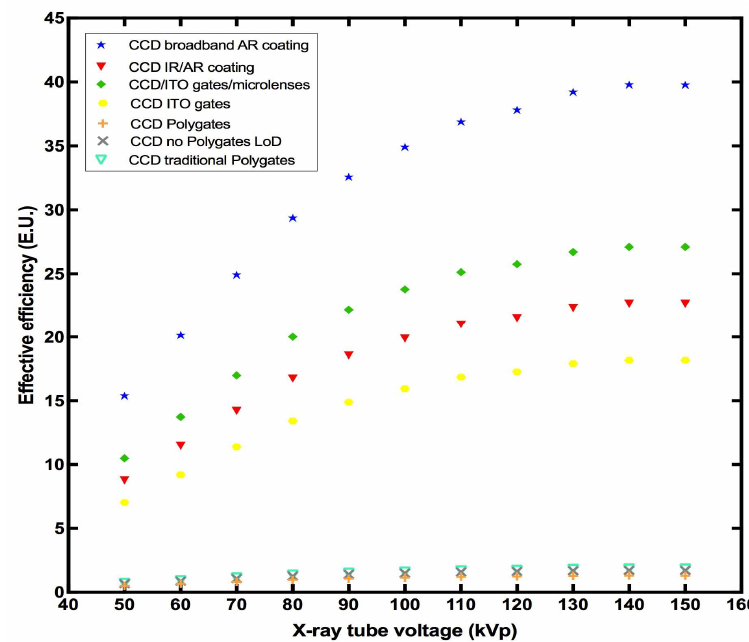
Figure 15. EE of LaBr 3 :Ce combined with various CCDs.